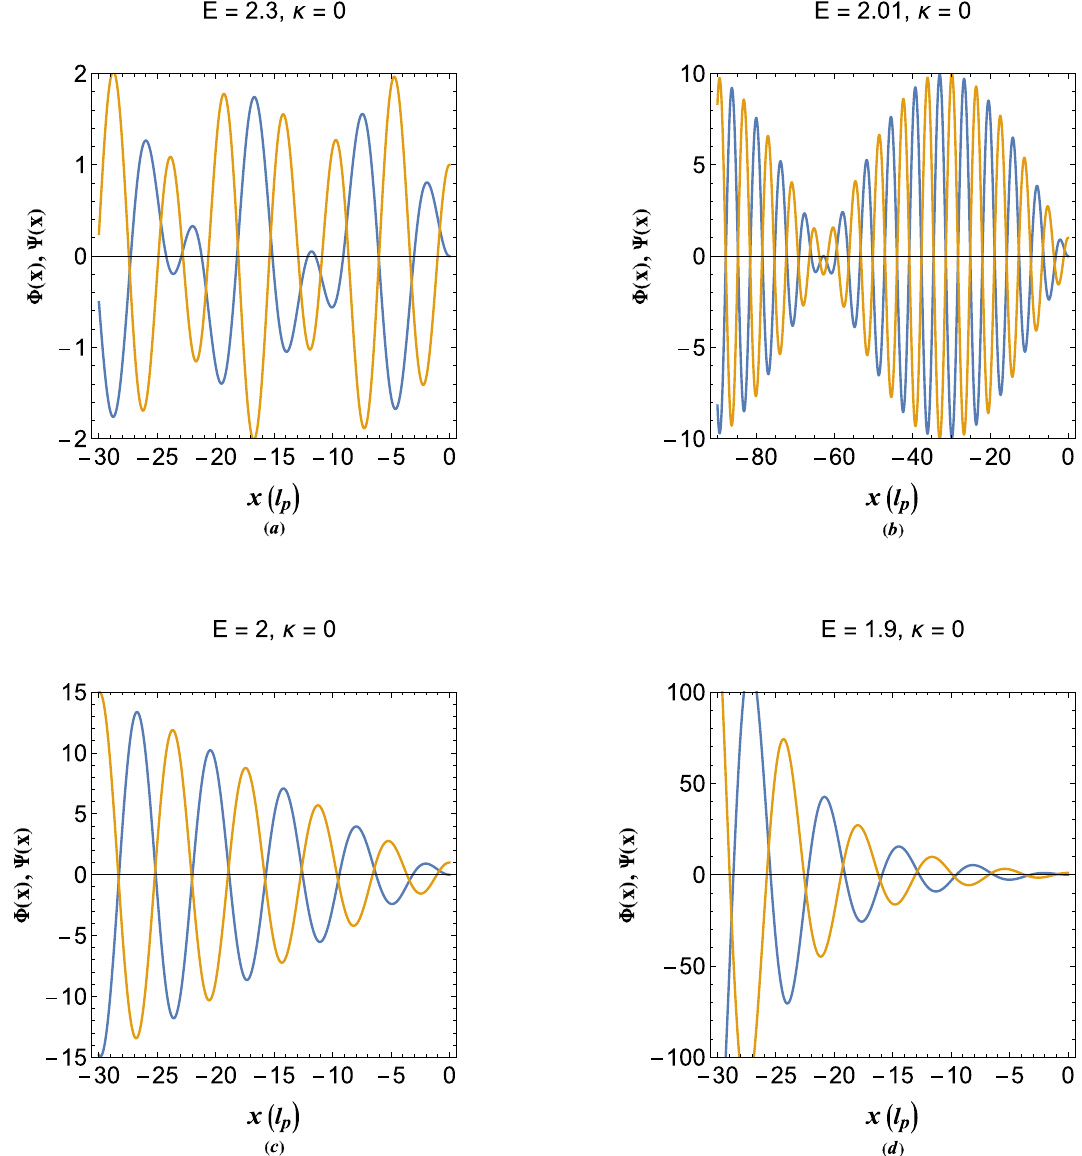
Figure 6. ( a ) The collective oscillation profiles of the local electron density and electrostatic energy of undamped plasmons at overcritical energy orbital (orbitals above the main exceptional point). ( b ) The collective oscillation profiles of the electron density and electrostatic energy of undamped plasmons at nearcritical energy orbital (the quantum beating state). ( c ) The collective oscillation profiles of the local electron density and electrostatic energy of undamped plasmons at exceptional-point energy orbital (orbital at the exceptional point). ( d ) The collective oscillation profiles of the electron density and electrostatic energy of undamped plasmons at undercritical energy orbital (orbitals below the exceptional point in plasmon energy gap